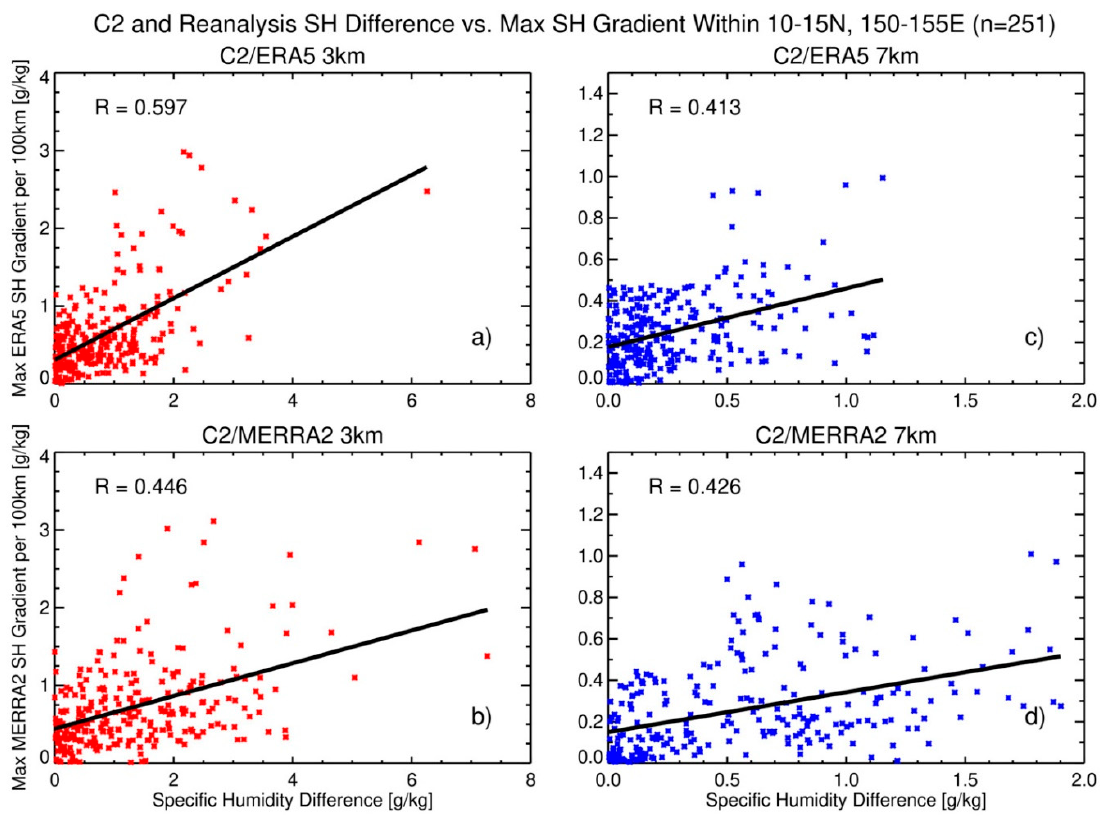
Figure 9. ( a , c ) Scatterplot of C2 and ERA5 specific humidity differences vs. the ERA5 local maximum moisture gradient per 100 km at 3 km and 7 km, and ( b , d ) C2 and MERRA-2 specific humidity differences vs. the MERRA-2 local maximum moisture gradient per 100 km at 3 km and 7 km within 10° N–15° N, 150° E–155° E from September–December 2019. The number of collocated profile pairs is shown in the title and the trend line and correlation coefficient are also shown on each panel.